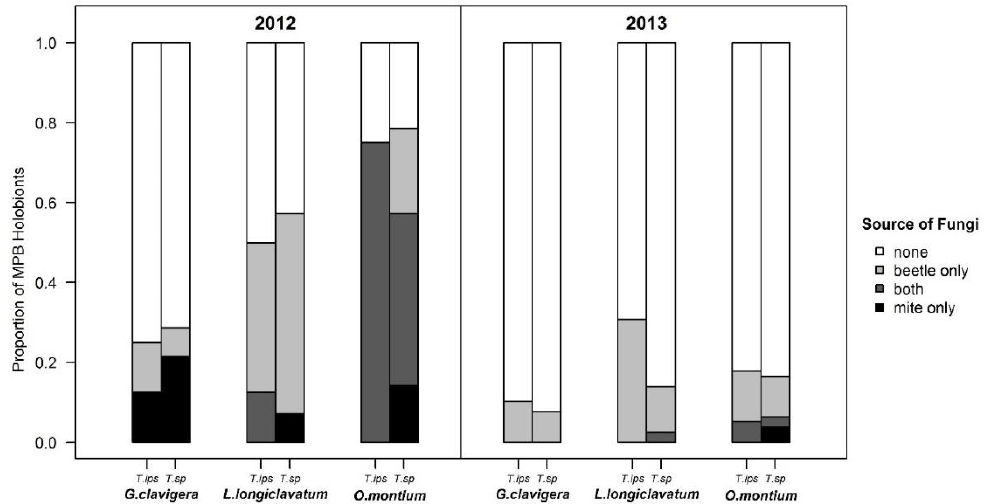
Figure 5. The frequency of three blue-stain fungi in mountain pine beetles (MPBs) that carried mites. The fractions represent the absence of blue-stain fungi (white), the fungus detected only on MPB (light gray), on Tarsonemus ips and Trichouropoda sp. ( T . sp.) mites alone (black), or on both MPB and mites (dark gray). In 2012, Tarsonemus ips contributed largely more G. clavigera into the MPB holobiont, but this effect was reduced in 2013 when a larger sample was examined. The overall fungal presence decreased largely in 2013 when mites only added O. montium to the holobiont. The proportions are shown in different columns for each mite.